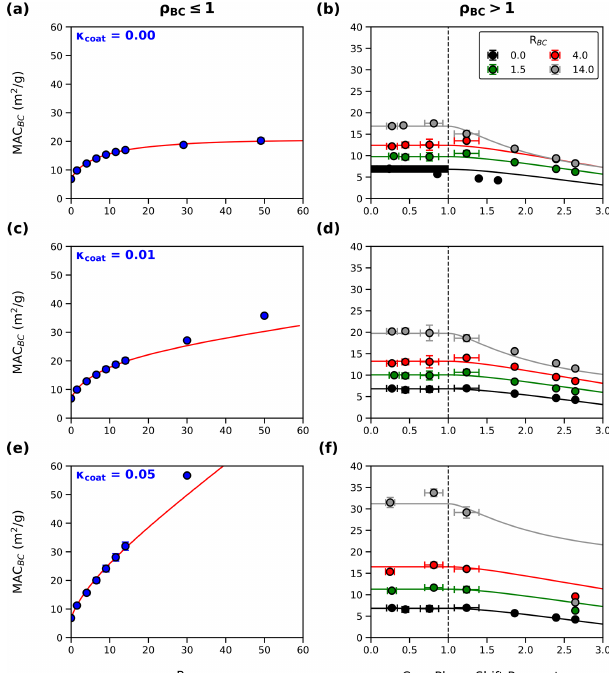
Figure 4. Data and fitting of MAC BC as a function of ρ BC and R BC for BC internally mixed with a coating imaginary refractive index ( κ coat ) of 0.00 (a–b) , 0.01 (c–d) , and 0.05 (e–f) . We find that for constant ρ BC , MAC BC increases with increasing R BC . Addi- tionally, for constant R BC , MAC BC decreases when ρ BC surpasses unity. Solid lines show the scaling of MAC BC given by Eq.